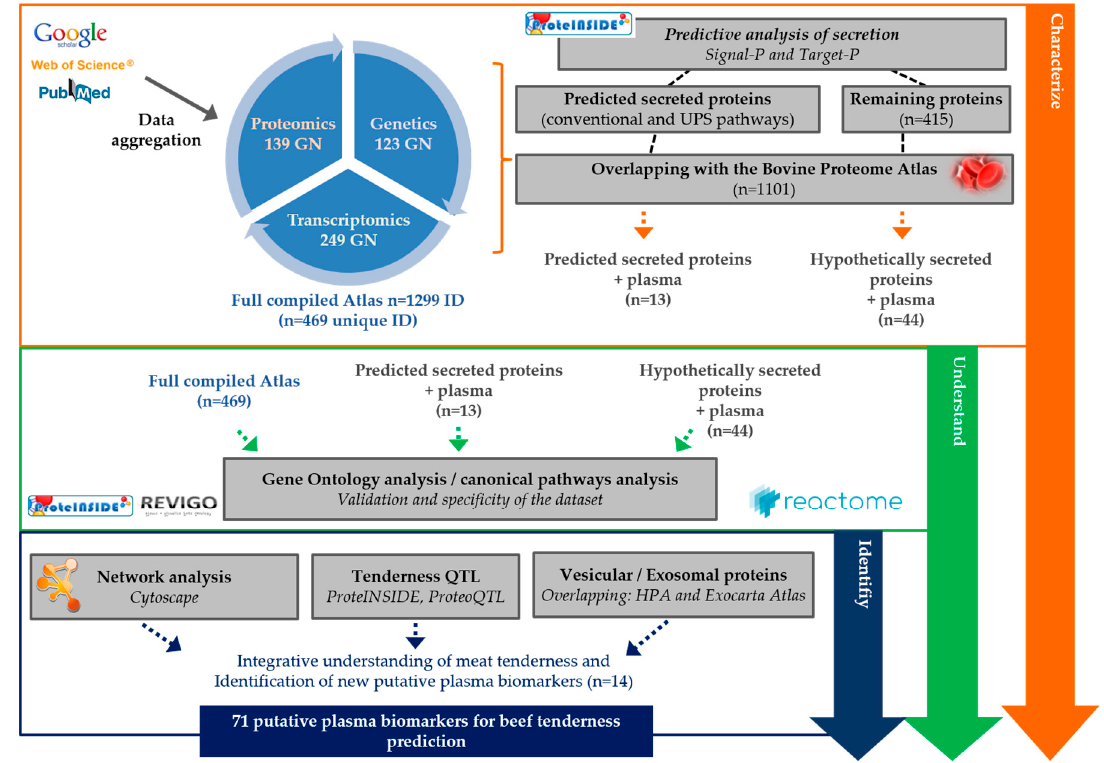
Figure 1. Flowchart of the workflow applied for the discovery of candidate plasma biomarkers for beef tenderness using a review of the literature and aggregation of omic data